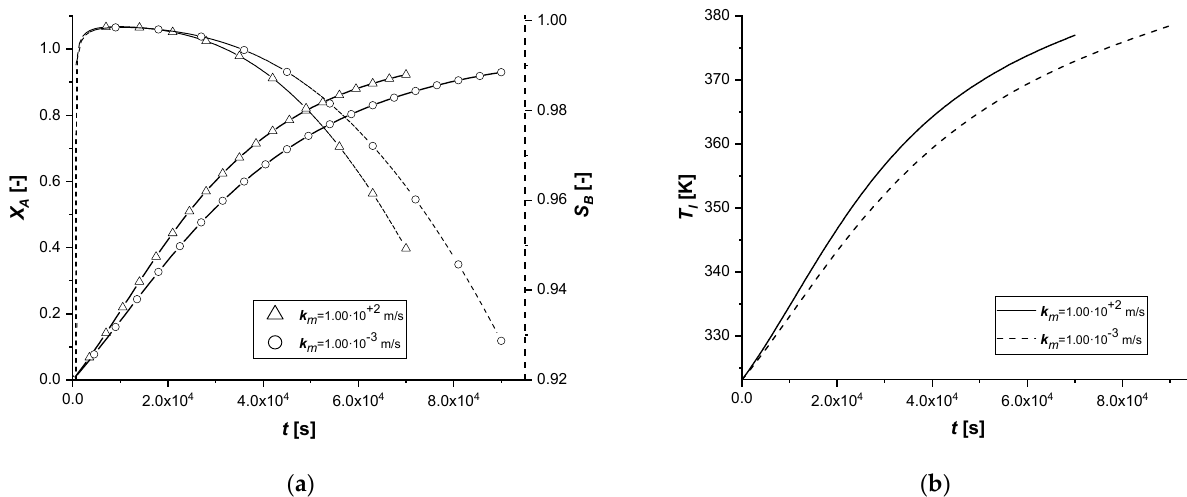
Figure 30. EW k m investigation. ( a ) Bulk profiles over time of X A and S B . ( b ) Bulk profile of T l over time.